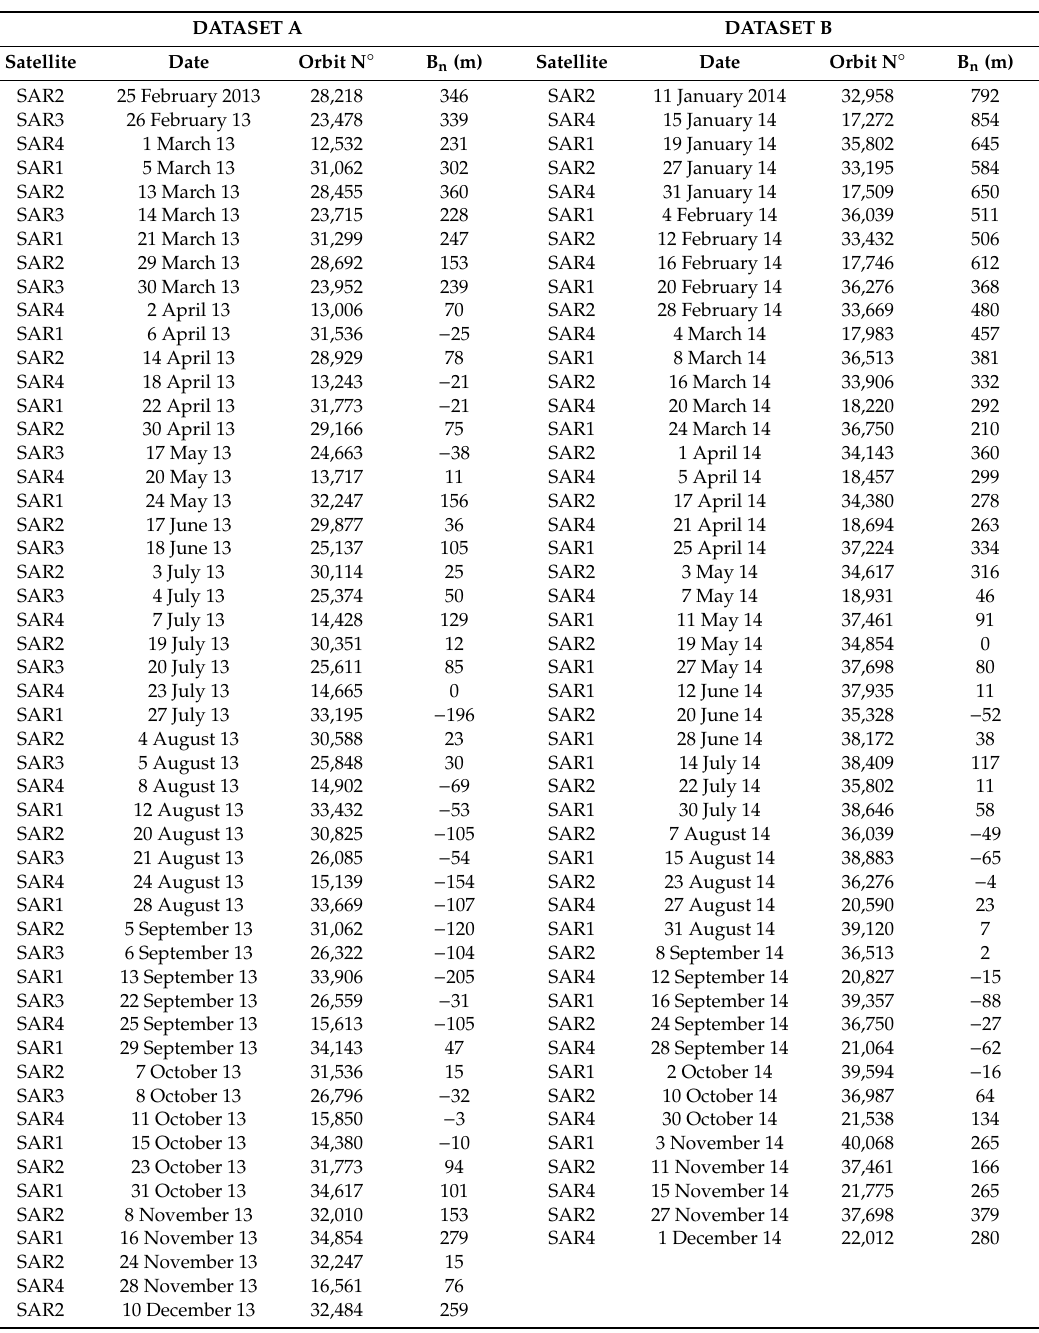
Table 2. Temporal distribution of the two datasets (dataset A and dataset B) of Synthetic Aperture Radar (SAR) images used for the A-DInSAR analyses. For each image the following information are reported: the satellite belonging to the COSMO-SkyMed constellation used for the acquisition, the date of acquisition, the orbit number as reported by ASI and the normal baseline (B n ) in meters with respect to the master image used for the dataset coregistration